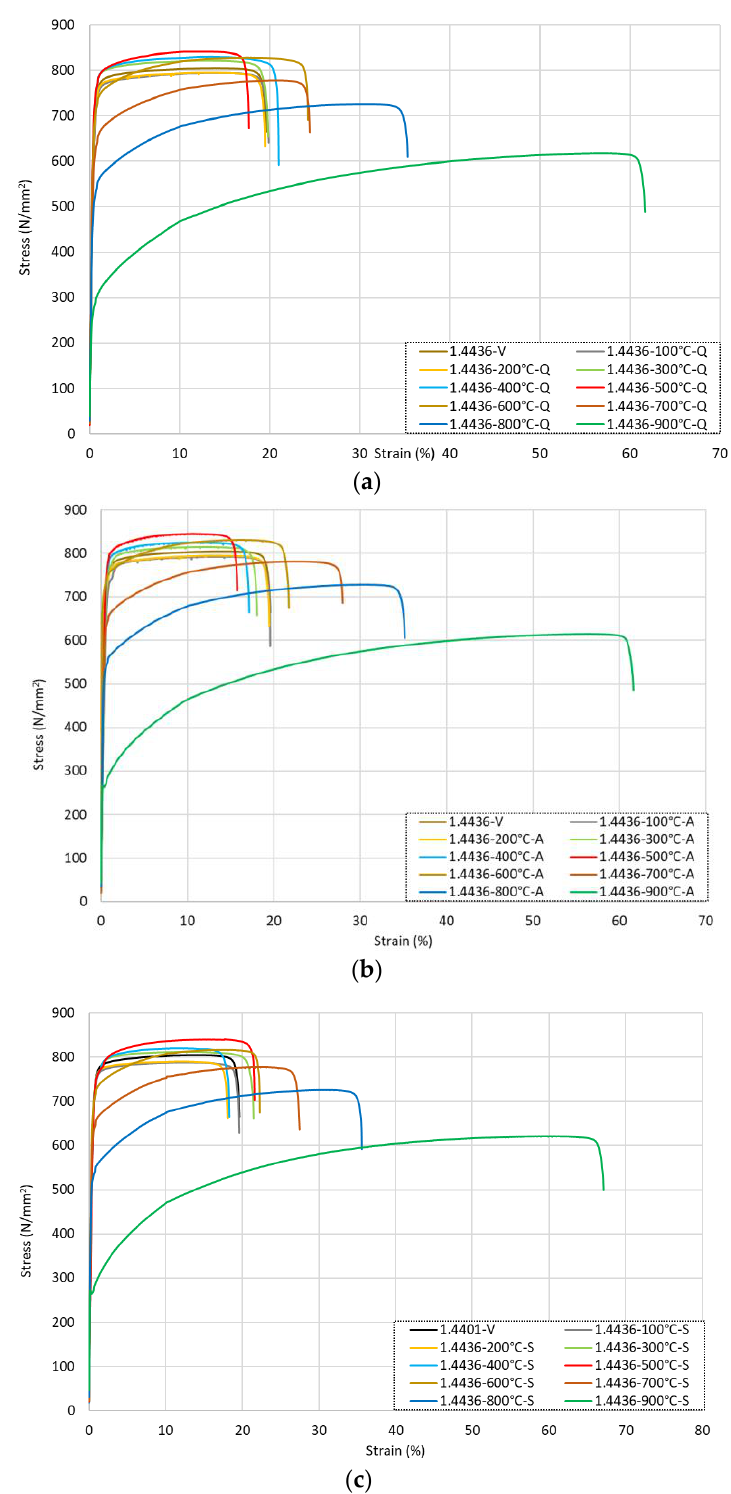
Figure 8. Stress–strain responses for grade 1.4436 stainless steel rebars following exposure to elevated temperatures and then being ( a ) quenched in water, ( b ) cooled naturally in air, or ( c ) slow-cooled in the furnace.